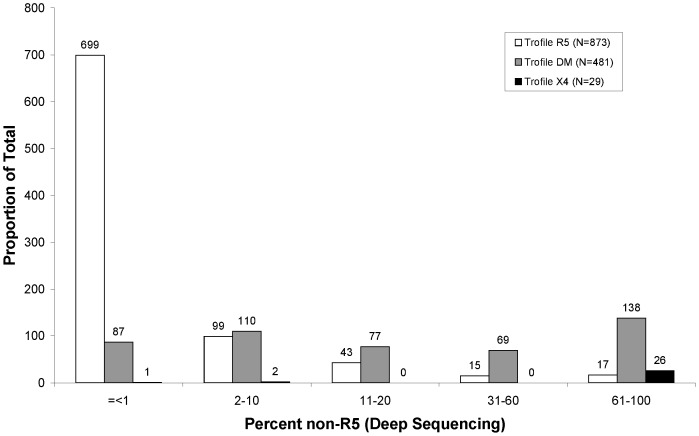
Histogram of percent non-R5 by Trofile call of patients in the MOTIVATE and A4001029 trials for which both population sequencing test results and original Trofile assay results were available (N = 1383).Patients are grouped according to the percent non-R5 measured by deep sequencing and Trofile call. R5 Trofile calls are shown in white. Dual Mixed Trofile calls are shown in grey. X4 Trofile calls are shown in black.